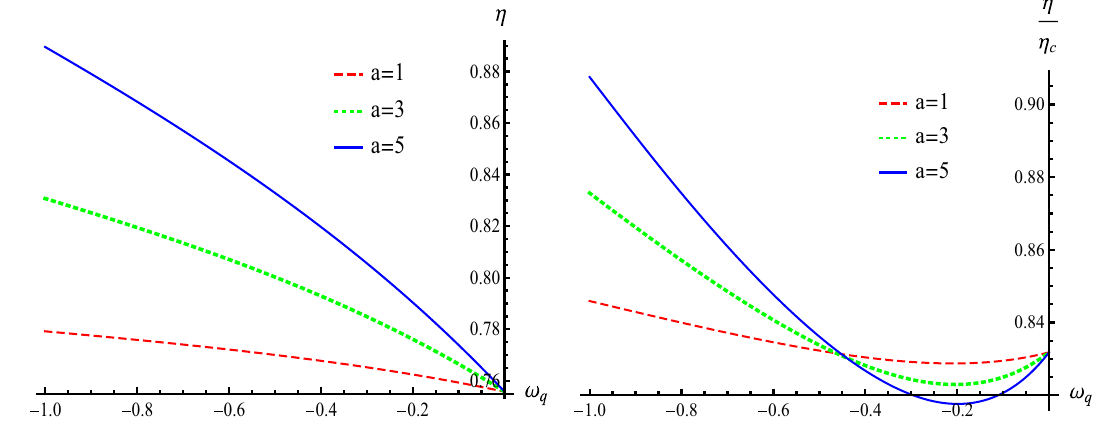
Fig. 10 The two figures above are plotted at three different fixed normalization factors a , here we take P 1 = 4 , P 4 = 1 , S 1 = 1 , S 2 = 4 , Q =